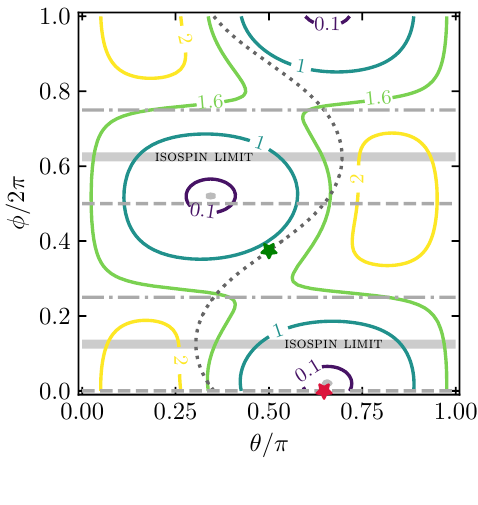
(b) Relative event rate along tan θ = 2 / (sin φ + cos φ ) .